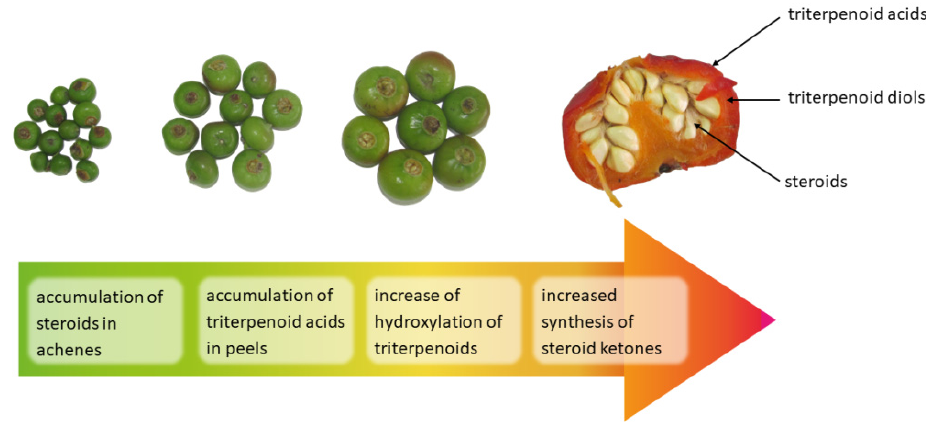
Figure 4. The main differences in accumulation of triterpenoids and steroids in anatomical parts of rugosa rose ( Rosa rugosa Thunb.) accessory fruits and characteristic processes observed during rip- ening and